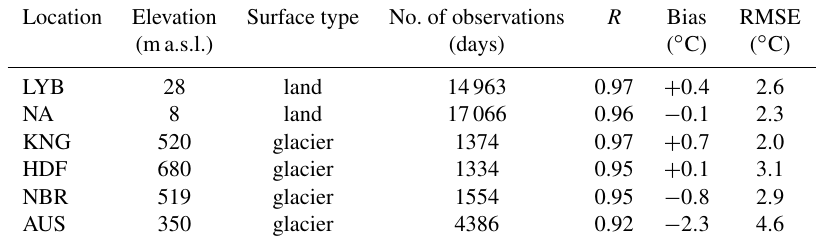
Figure 4. Comparison of simulated glacier-wide summer, winter and net mass balance against WGMS records for KNG (a) and HBR (b) . Table 3. Comparison of downscaled and observed air temperatures at glacier- and land-based weather stations. Location Elevation Surface